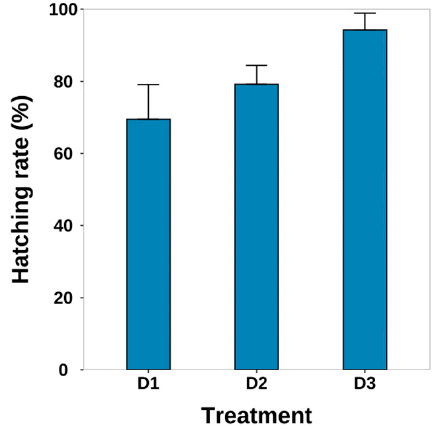
Figure 5. Hatching rate (%) of ovigerous P. clarkii in different shelters after 25 days.